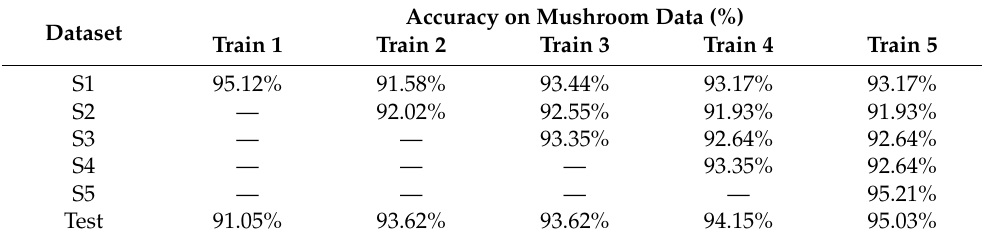
Table 6. Result of ISVM_DD on mushroom data.